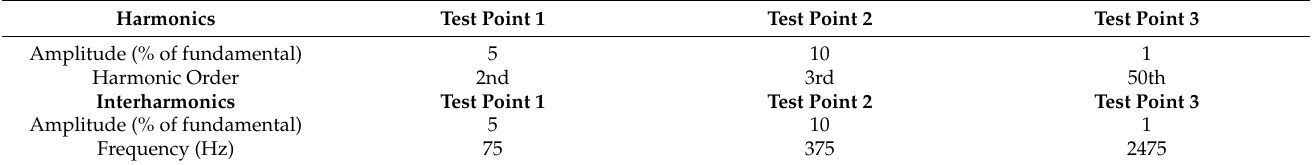
Table 6. Proposed test point for amplitude and frequency deviations.